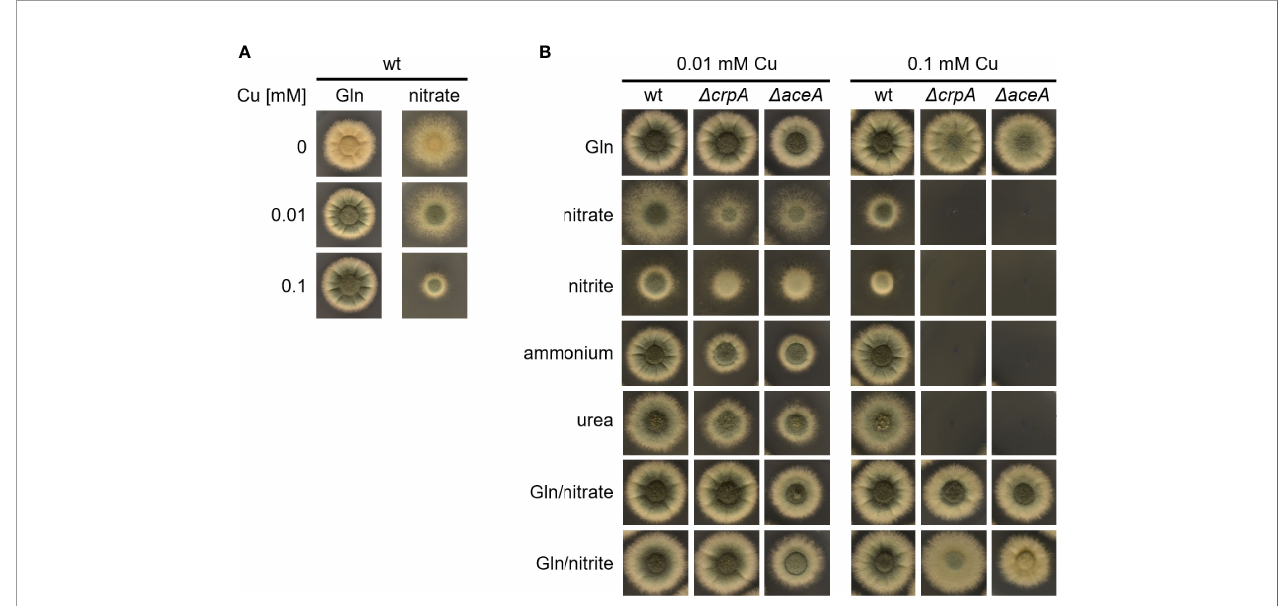
FIGURE 1 | Gln protects A . fumigatus against Cu toxicity. (A) A . fumigatus wt conidia were point-inoculated on solid AMM containing 0, 0.01, or 0.1 mM Cu with either Gln or nitrate as nitrogen source. (B) To analyze the effect of the nitrogen source on Cu resistance, A. fumigatus wt, D crpA , and D aceA conidia were point- inoculated on solid AMM containing either 0.01 or 0.1 mM Cu in combination with different nitrogen sources (in case of combination of two nitrogen sources, the same concentration of each was